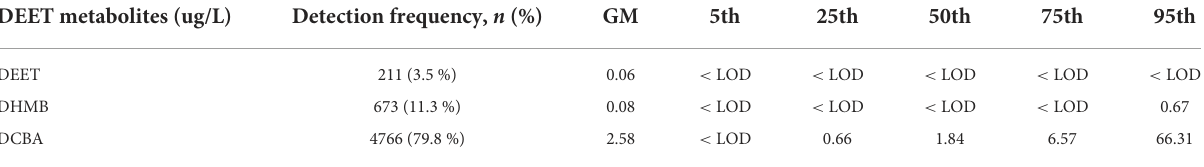
TABLE 3 Distribution of urinary DEET and its metabolites ( N = 5,972), NHANES 2007–2014. DEET metabolites